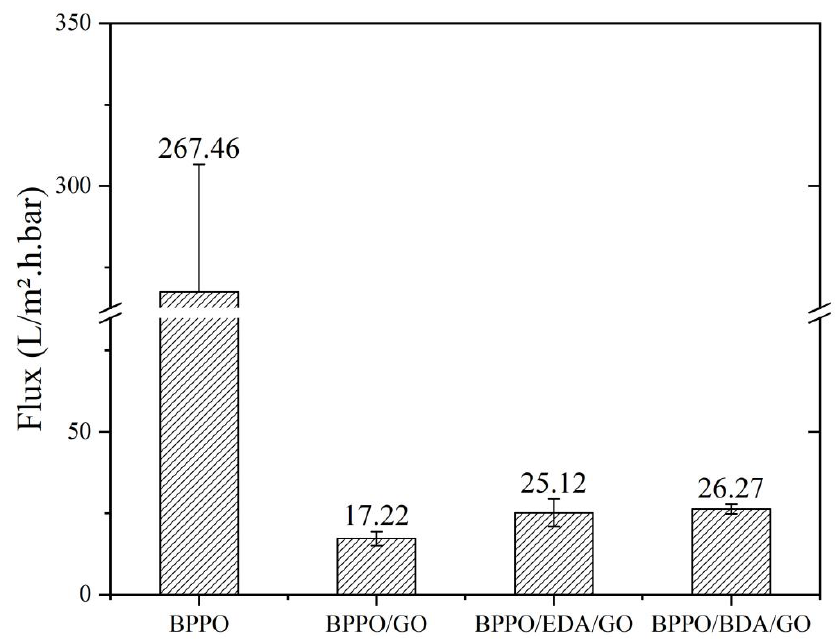
Figure 6. Flux of BPPO/AX-GO-modified nanofiltration membranes.